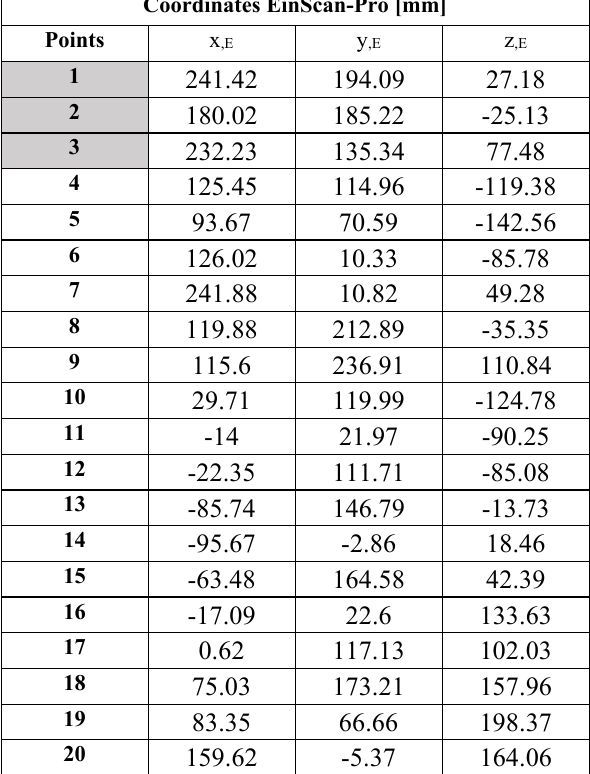
Table 12. Standard deviation calculation EinScan-Pro - Artec